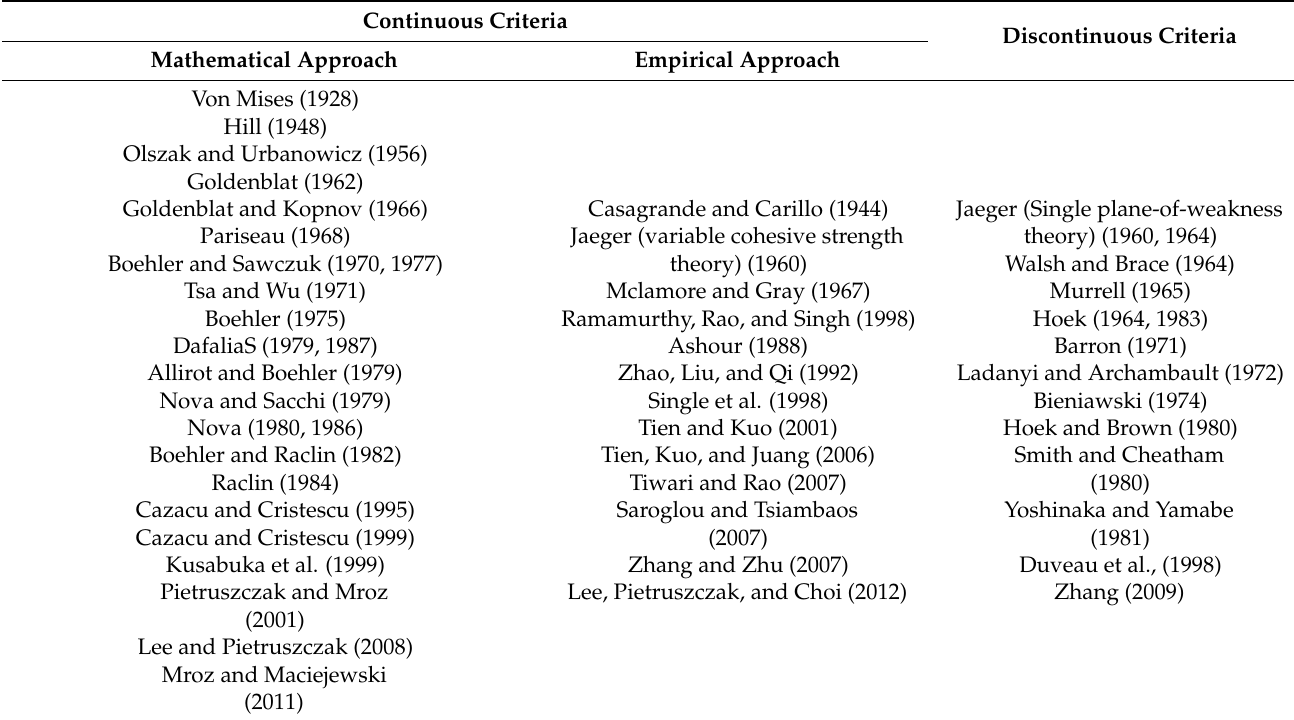
Table 20. Classification of widely used anisotropic failure criteria (Adapted from Ambrose [133]. The mentioned references in the table are from